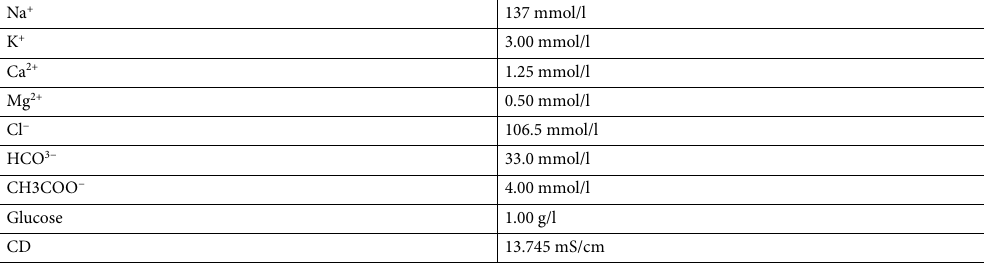
Table 3. Composition dialysate (freshly made prior to each